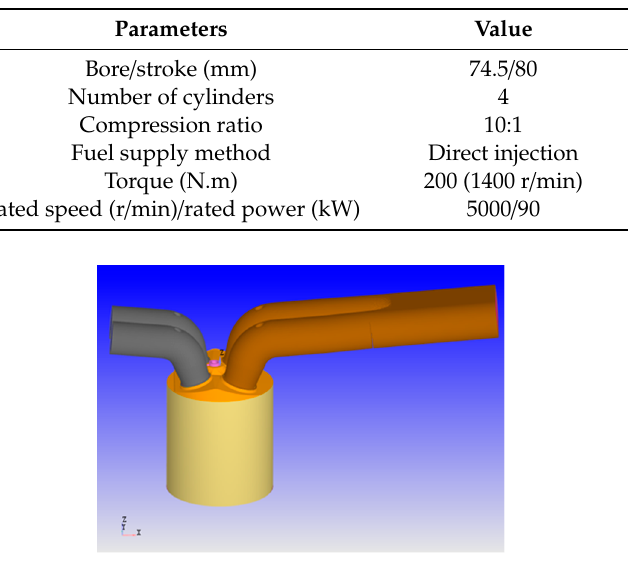
Table 1. Main specifications of the engine.